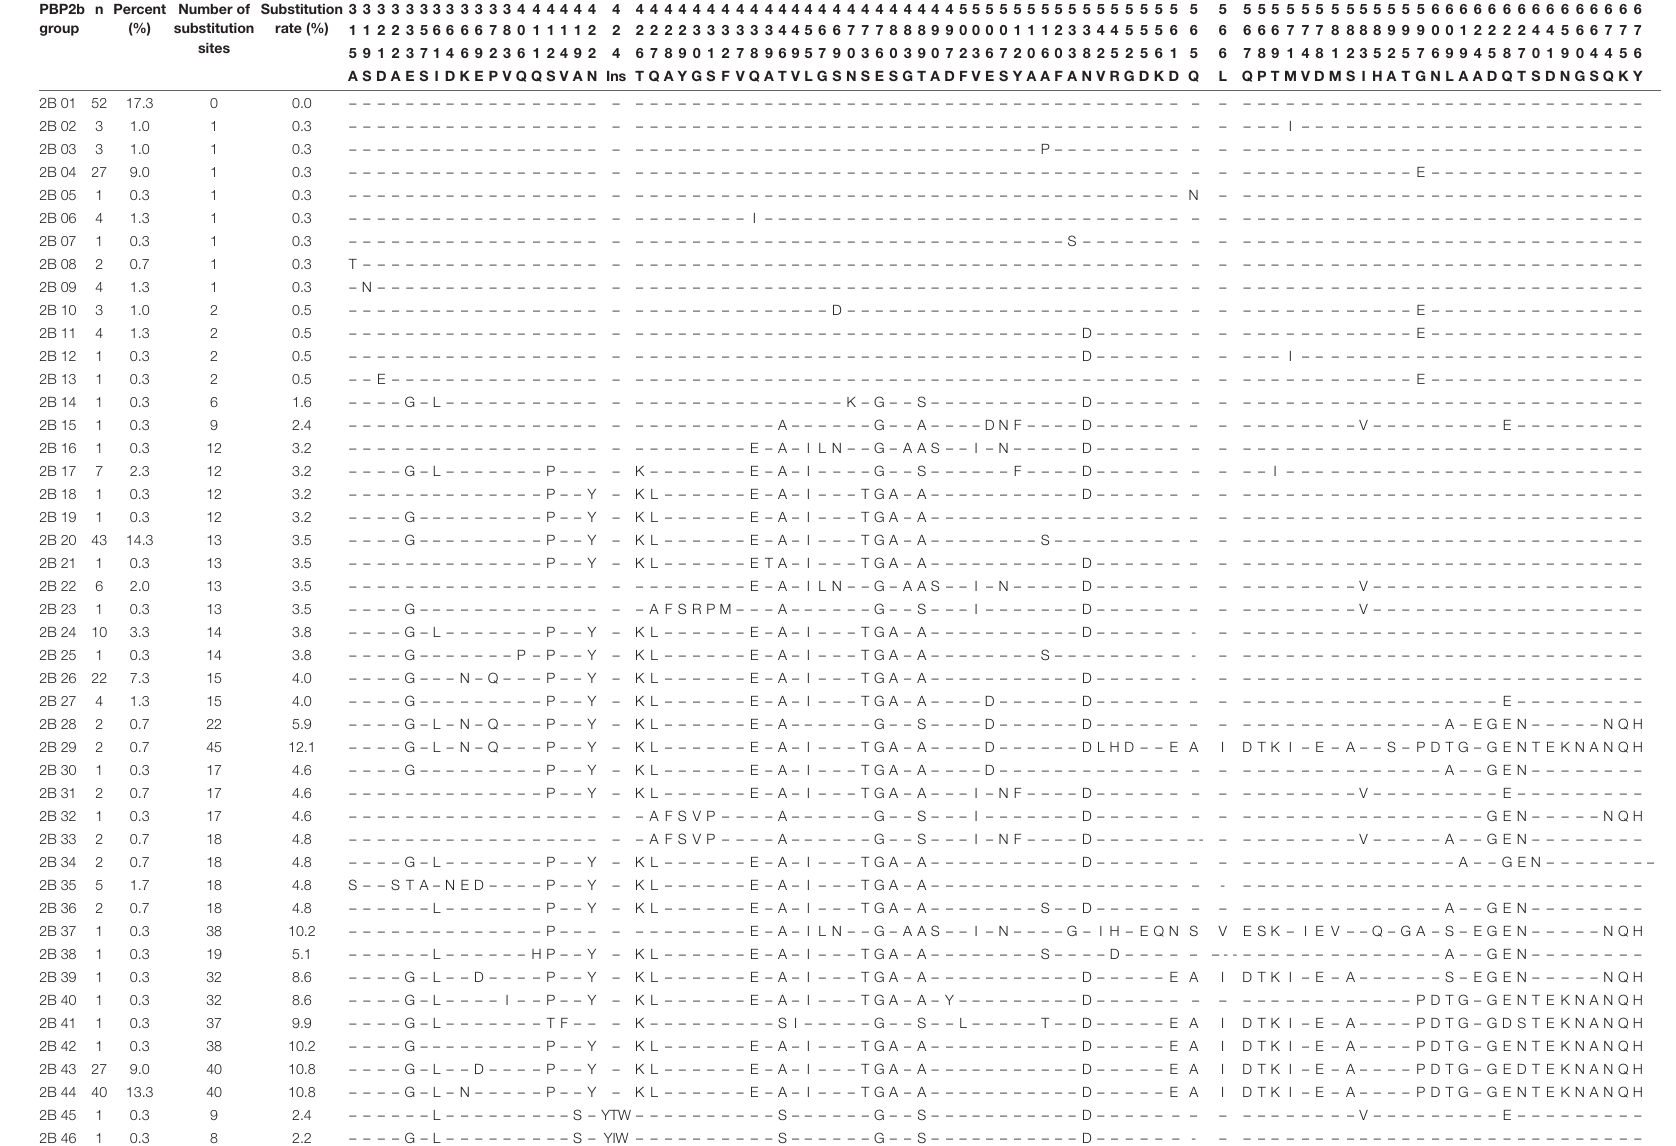
TABLE 8 | Deduced amino acid sequences of PBP2b in 300 S. pneumoniae isolates. PBP2b n Percent Number of group (%) substitution